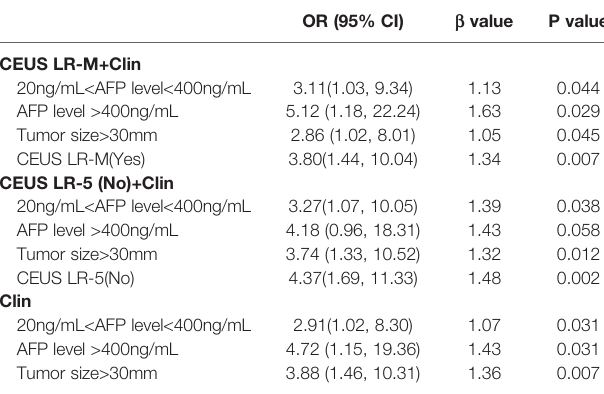
TABLE 2 | Multivariate analysis of clinical and CEUS LI-RADS features for predicting MVI in training cohort. OR (95% CI) b value P value